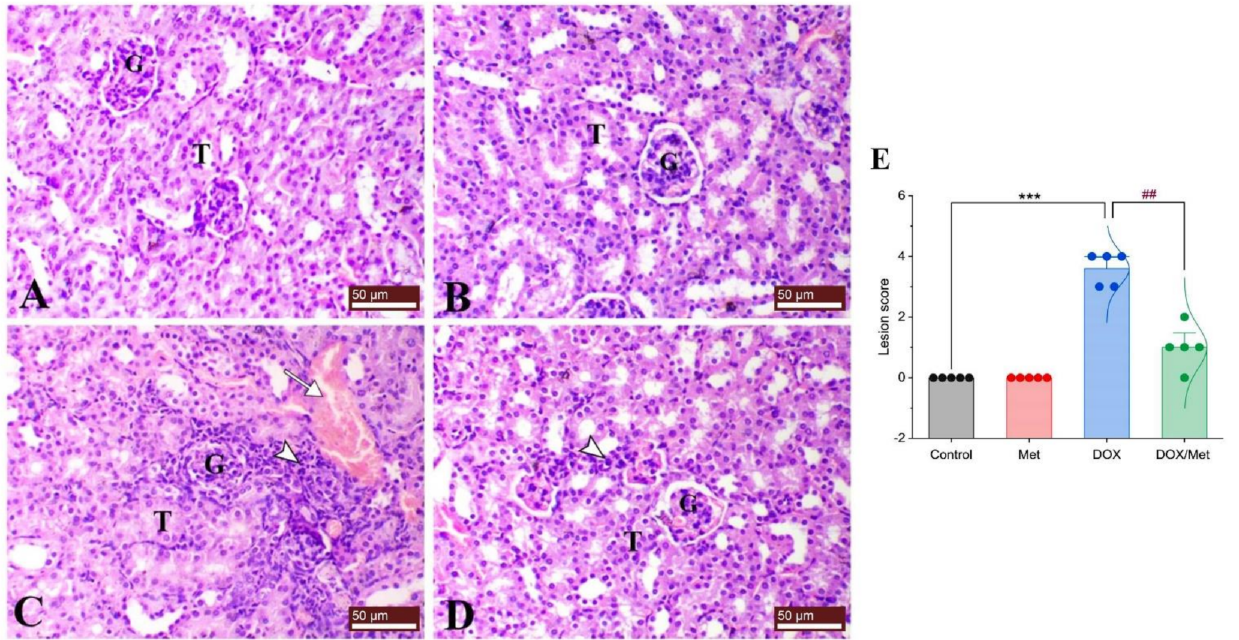
Figure 3. Protective effect of Met against histological alterations in renal tissue injured by DOX. ( A ) control group, ( B ) Met-treated group, ( C ) DOX-intoxicated group, and ( D ) DOX/Met group. ( E ) Bar-dot plot of the histopathological scoring. Tailed arrows indicate vascular congestion and arrowhead indicates interstitial inflammatory cell infiltrations. The Mann–Whitney U test was used for statistical comparisons. Data are expressed as mean ± SEM. Colored dots indicate each individual value and colored curves represent the distribution of each data point. *** p < 0.001 vs. control group and ## p < 0.01 vs. DOX group. (H and E stained; G, glomerulus; T, renal tubule; bars = 50 µ